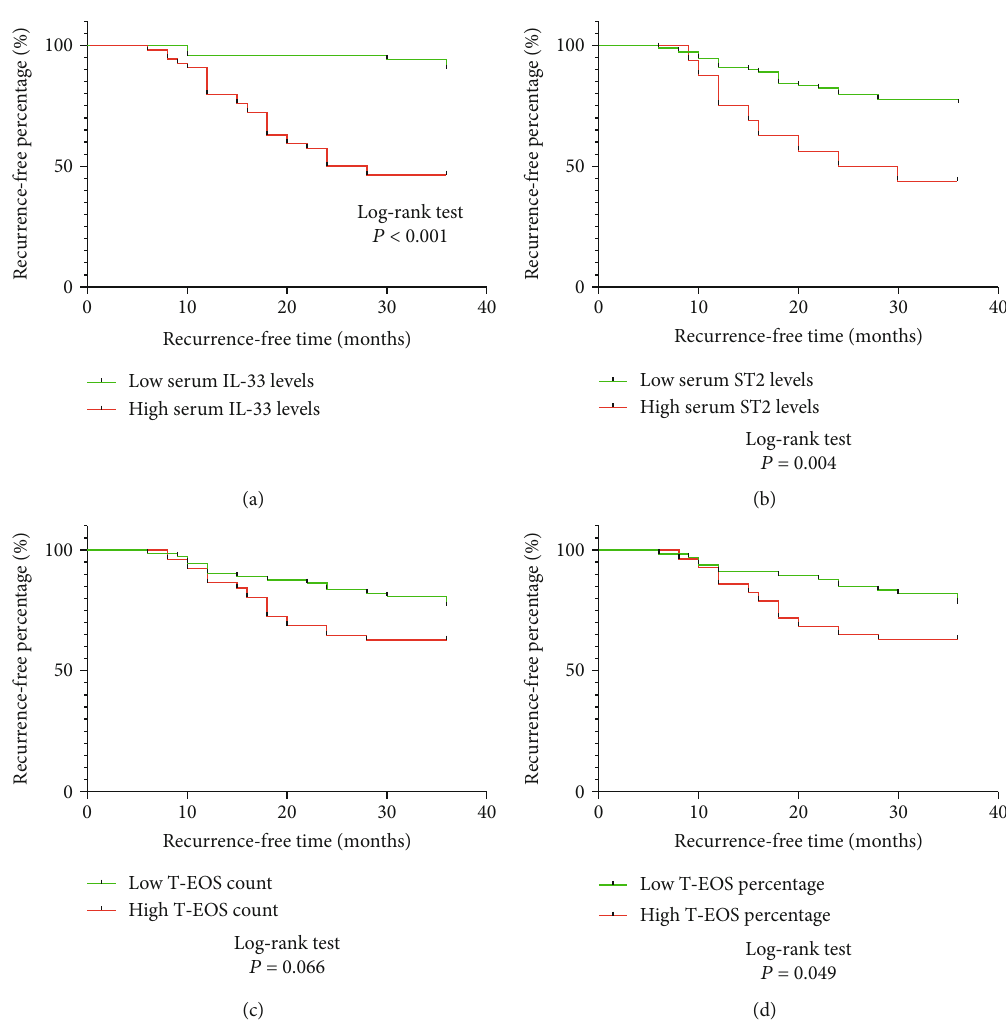
Figure 5: Kaplan-Meier plots of candidate biomarkers for predicting recurrence in CRSwNP patients. Serum IL-33 (a), sST2 (b), and T-EOS percentage (d) showed signi fi cant di ff erences in predictive power ( P < 0 : 05 ), but T-EOS count (c) did not. CRSwNP: chronic rhinosinusitis with nasal polyps; IL-33: interleukin-33; sST2: soluble suppressor of tumorigenicity 2; T-EOS: tissue